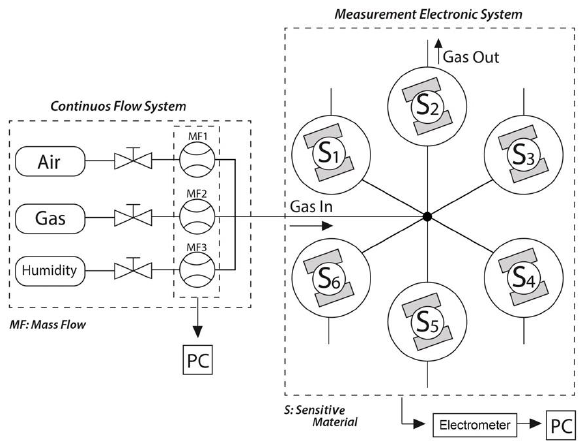
Figure 2. Schematic of the sensor test facility showing the gas lines passing through the mass flow controllers (MF) to the six sensors (S1 – S6) characterized simultaneously.